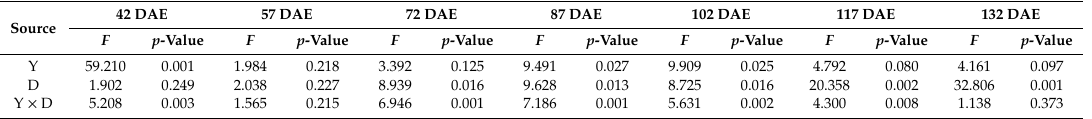
Table 8. Analysis of variance for the effect of year (Y) and plant density (PD) on boll load.